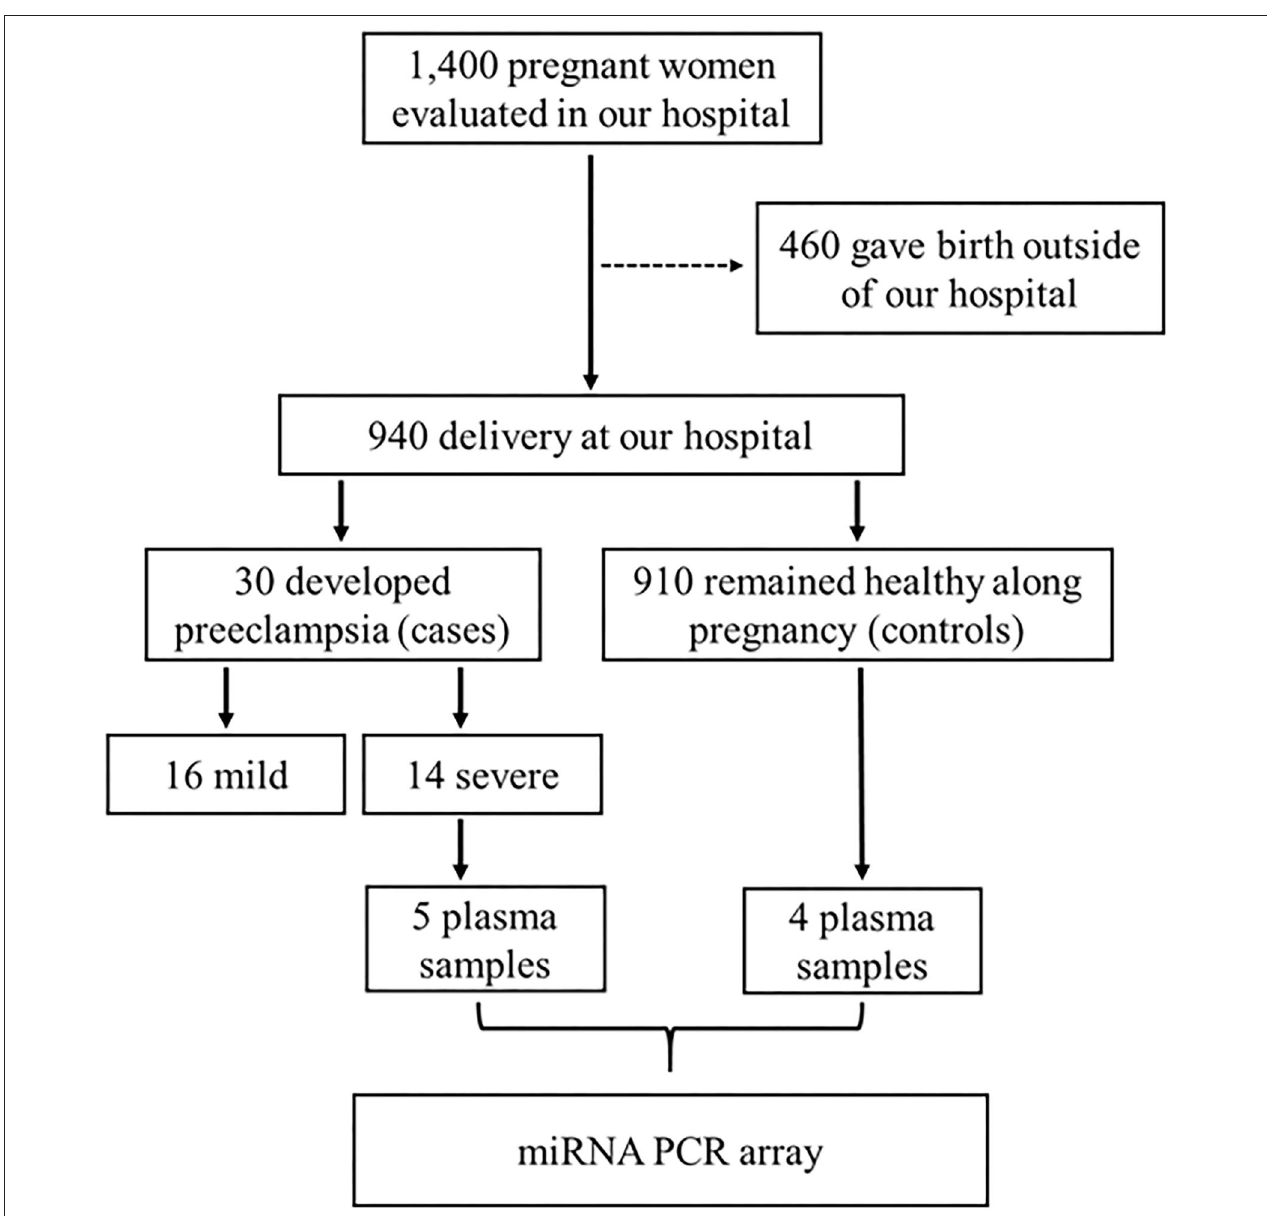
FIGURE 1 | Schematic diagram of the study workflow for the inclusion of subjects, and the selection of plasma samples from pregnant women who developed severe preeclampsia (case group) or those who remained healthy during pregnancy (control group), which were used in the PCR array. This case-control study is based in a prospective cohort named Brazilian Ribeirão Preto and São Luís prenatal cohort (BRISA) (da Silva et al., 2014; Pereira et al., 2016; Caldeira-Dias et al., 2019).